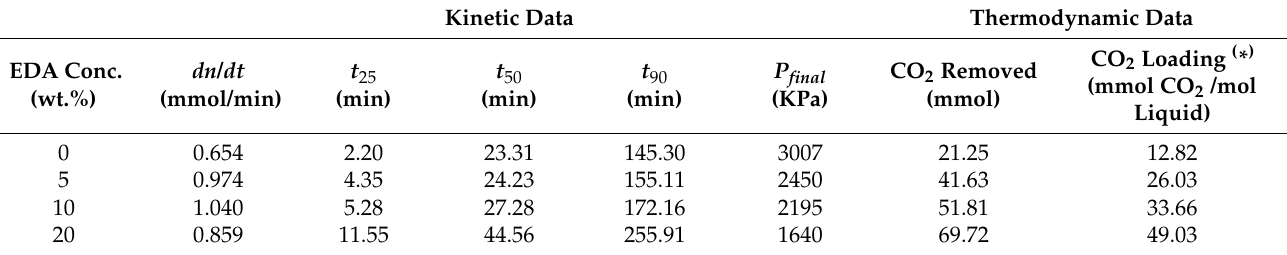
Table 2. CO 2 capture using EDA: Kinetic and thermodynamic